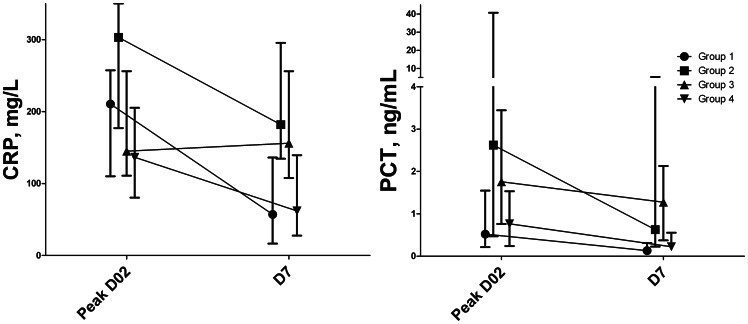
Evolution of C-reactive protein and procalcitonin according to evolution of infection (I) in febrile critically ill patients.CRP and PCT levels presented as median (interquartile range). Group 1=I Day (D)0-2 no I D3-7; Group 2=I D0-2 and I D3-7; Group 3=no I D0-2 but I D3-7; Group 4=no I D0-2 nor D3-7. For CRP D0-2 P=0.009, for CRP D7 P=0.002, for change P=0.004; for PCT D0-2 P=0.054, PCT D7 P<0.001, for change P=0.23, among groups.